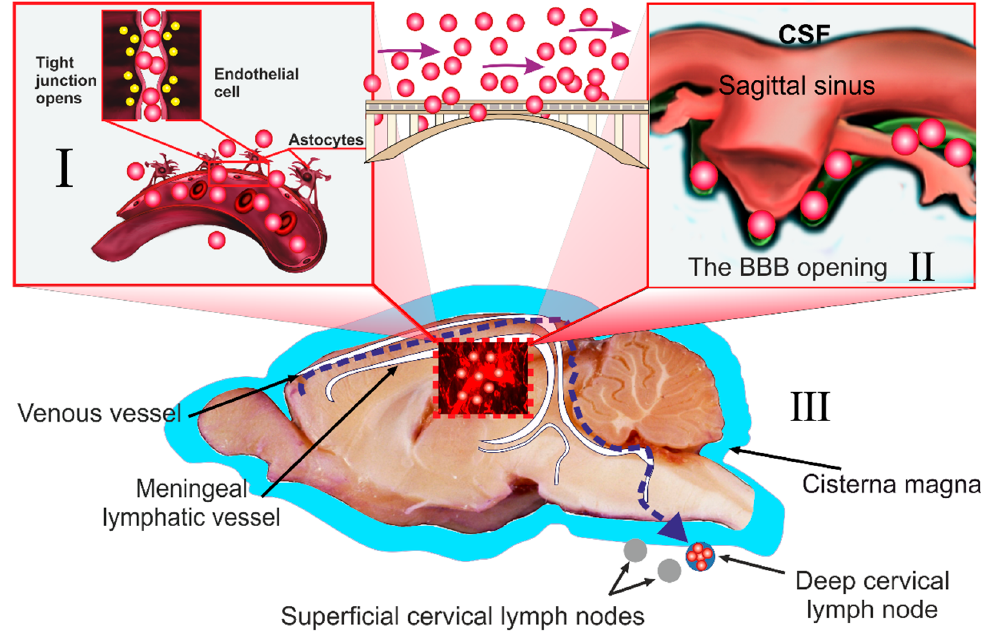
Figure 2. The illustration of hypothesis of OBBB-induced activation of drainage and clearance of the brain : ( I ) The OBBB is accompanied by transport of soluble molecules and fluids from the blood vessels to the brain parenchyma. ( II ) The MLVs are pathway of removing of molecules from the brain after its crossing OBBB. ( III ) The dcLNs are the first anatomical station of lymphatic clearance of molecules crossing OBBB.